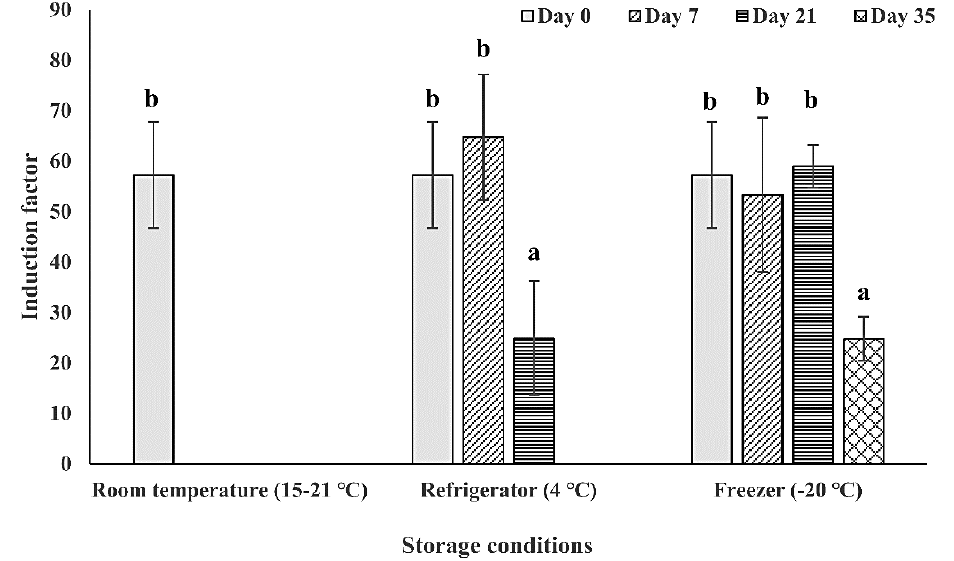
Figure 6. E ff ect of the storage temperature and duration on the bacterial sensitivity. The bioreporter bacteria cells from strain TV1061 were immobilized on the filter membrane and stored in di ff erent temperatures: Room temperature (15–21 ◦ C), 4 ◦ C, and − 20 ◦ C for the di ff erent durations (0, 7, 21, and 35 days). Their sensitivity to 2% ( v / v ) ethanol was then tested. All the values in the graph are presented as mean ± standard error of the mean (SEM), with di ff erent letters above the bars that indicate significant di ff erences ( p < 0.05), which were tested by the Fisher’s Least Significant Difference.